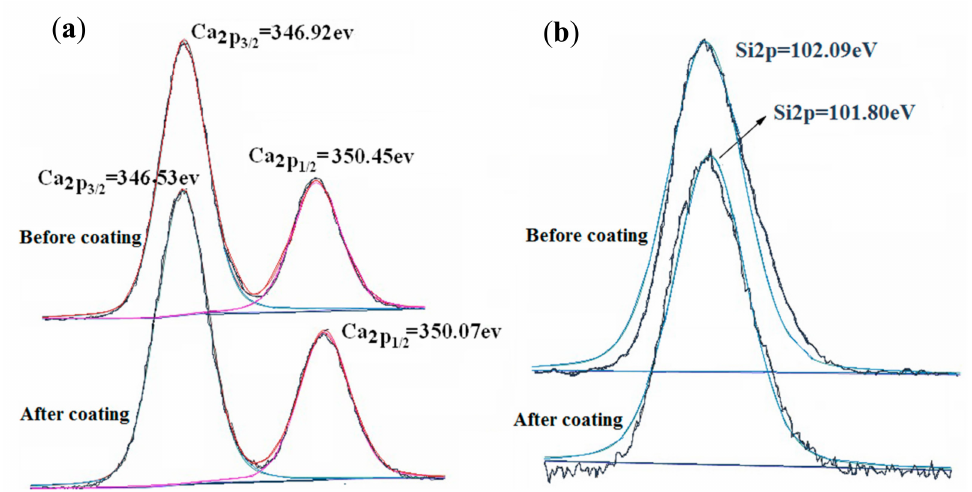
Figure 7. X-ray photoelectron spectra (XPS) of wollastonite before and after coated by TiO 2. ( a ) Ca 2p3/2 ( b ) Si 2P